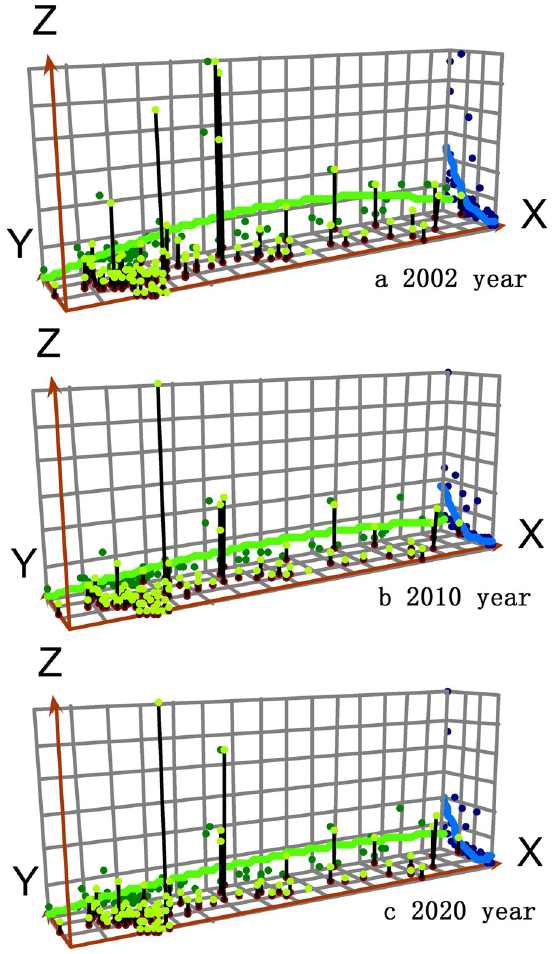
Fig 4. Global trend analysis of the per capita GDP in the Russian Federation from 2002 to 2020. Note: The X and Y axes are the east and north directions of the Russian Federation respectively. The Z axis is the per capita GDP of each federal subject. The green curve indicates the economic trend from east to west, and the blue curve indicates the economic trend from north to south.